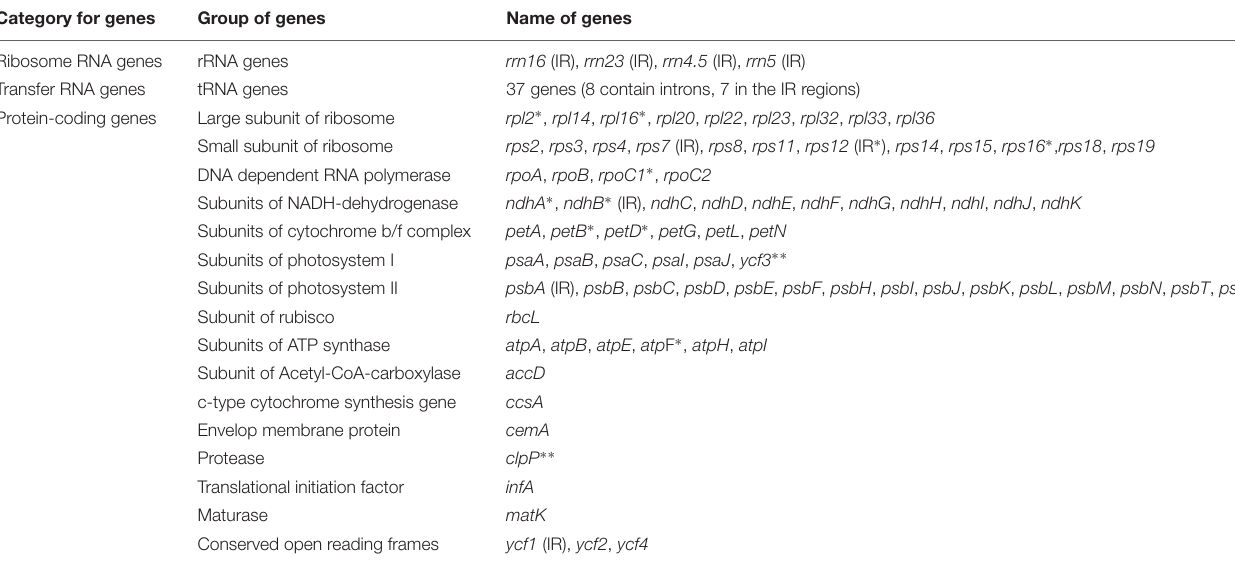
TABLE 1 | Genes contained in the S. cusia cp genome (a total of 113 genes).